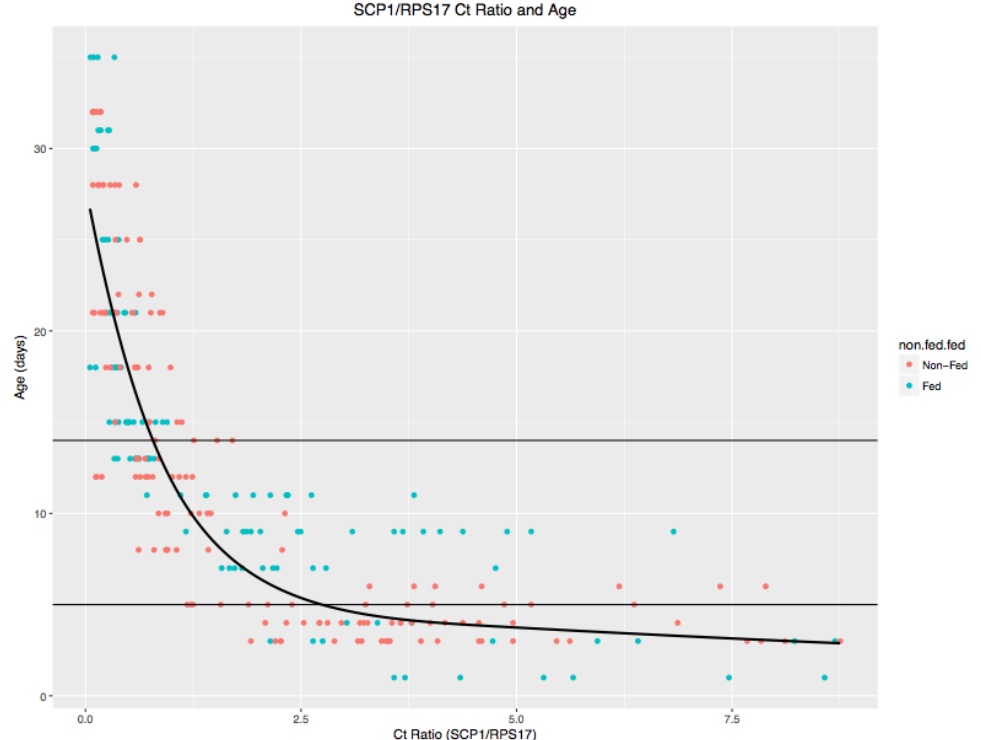
Figure 2. Ct Ratio and Age relationship. The RNA extraction protocol was changed after the initial Joy et al. 2012 paper [26] to eliminate problems caused by extraction from mosquito abdomens. New thresholds were identified (and used in Ernst et al. 2017 [27]): Ct ratio ≥ 1.92: ≤ 5 days old; 0.78 ≤ Ct ratio < 1.92: 6–14 days old; Ct ratio < 0.78: > 14 days old. The new regression model is shown above, with mosquitoes colored by their feeding status. The best-fit linear regression model is shown (bold black line): log(age)~rcs(Ct ratio, 3), where rcs represents a restricted cubic spline with three knots. Fed and non-fed mosquitoes did not differ significantly in their expression profiles ( p = 0.313; Wald test of regression coefficient for feeding